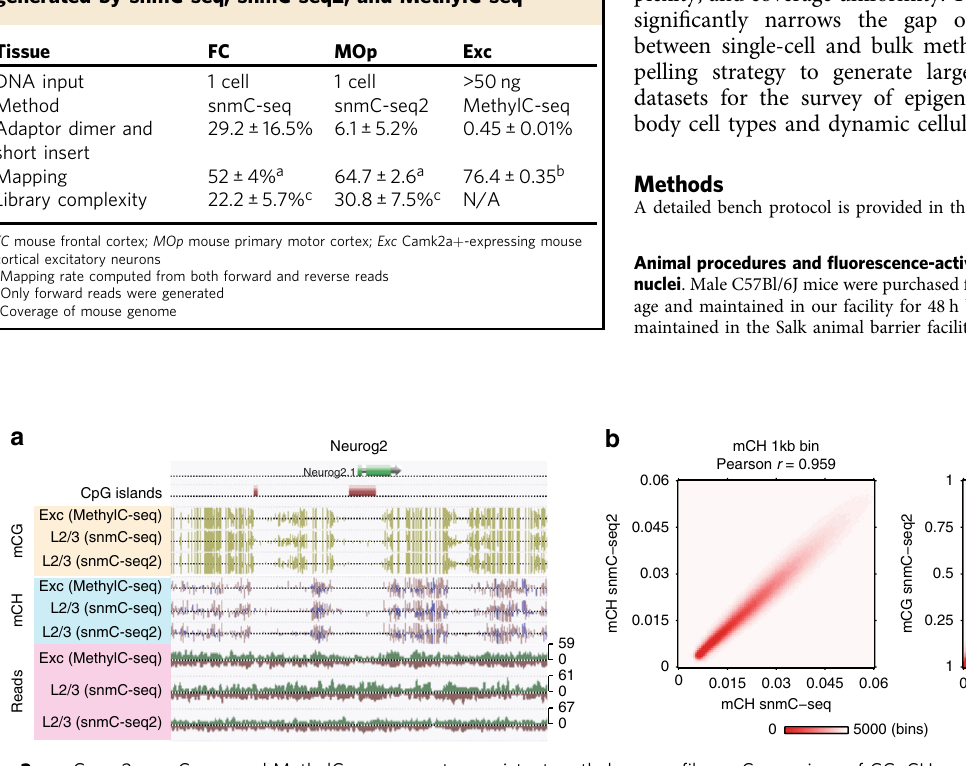
Fig. 3 snmC-seq2, snmC-seq, and MethylC-seq generate consistent methylome pro fi les. a Comparison of CG, CH methylation, and read coverage in the region surrounding Neurog2. L2/3 indicates combined methylome pro fi les of layer 2/3 excitatory neuron clusters. b Correlation of CH and CG methylation by snmC-seq2 and snmC-seq were compared for 1 kb genomic bins and CG-DMR regions, respectively. mCG, CG methylation; mCH, CH